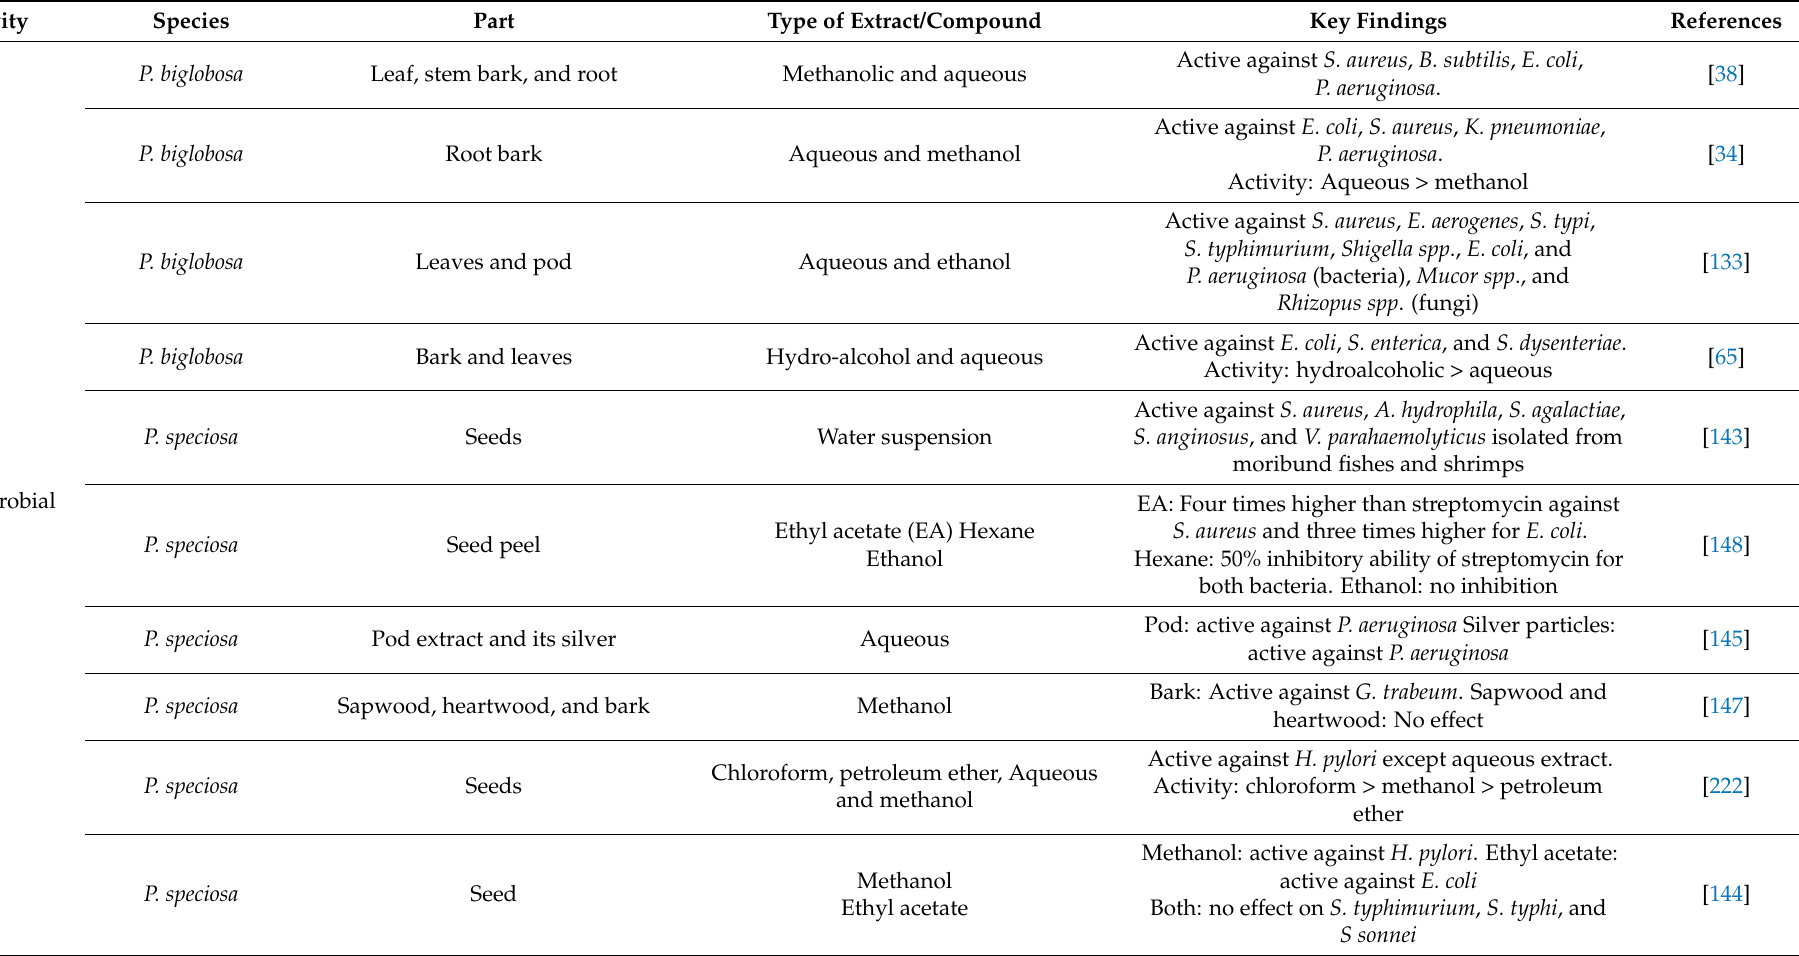
Table 3. Pharmacological activities of Parkia species extracts and